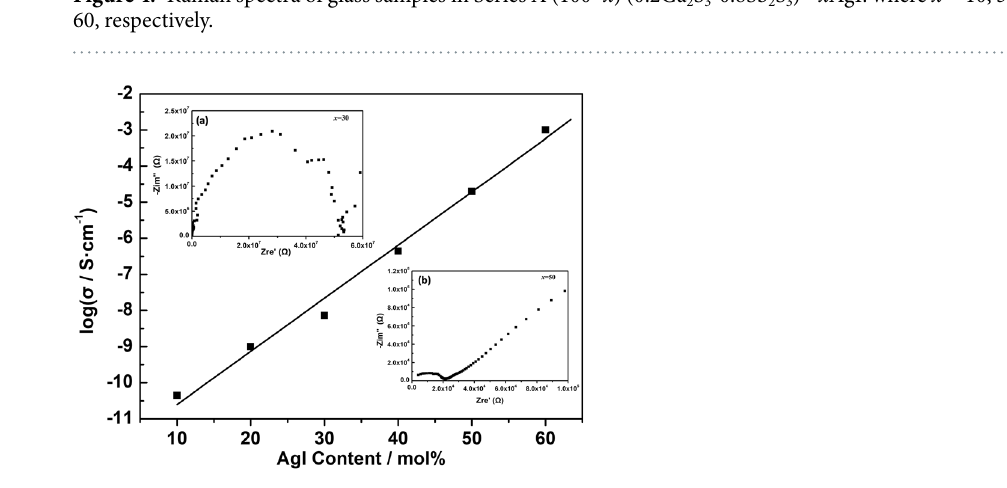
Figure 5. Ionic conductivity at room temperature (30 °C) of the glassy samples in Series A as a function of AgI content. The inset ( a ) and ( b ) present the Nyquist plots of impedance measured for the glass with composition of 70(0.2Ga 2 S 3 -0.8Sb 2 S 3 ) − 30AgI and 50(0.2Ga 2 S 3 -0.8Sb 2 S 3 ) − 50AgI,